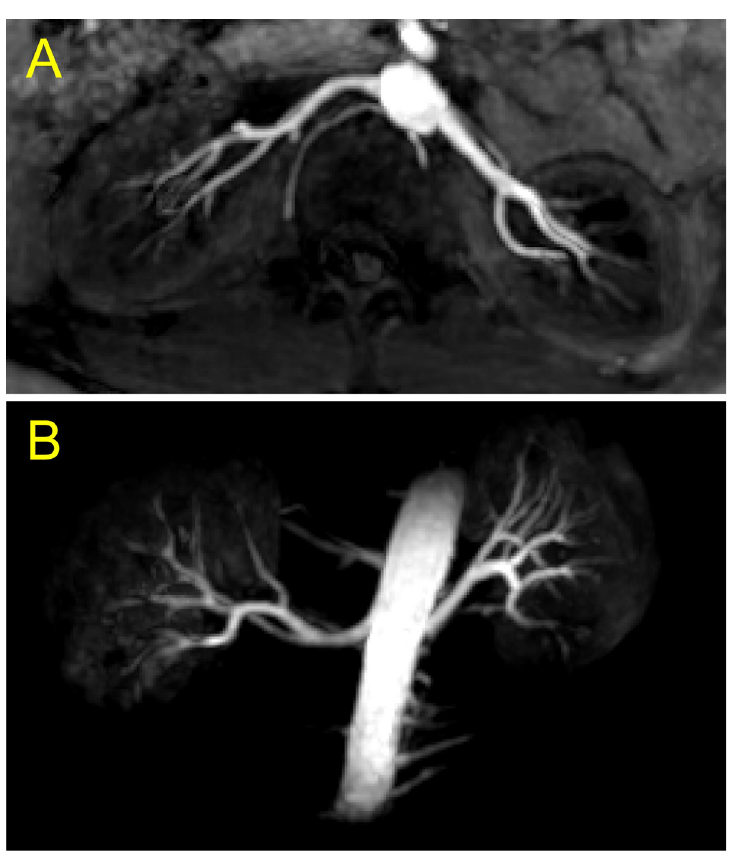
Fig 9. Maximum intensity projection (MIP) of a SoS-bSSFP renal angiography image. Projection was calculated with a 1.5-cm thick slab in axial view (A) and the entire kidneys in coronal view (B). To clearly show renal arteries, surrounding tissues except kidneys and arteries were masked out in B. MIP images projected onto other image planes are shown in S2 Video.